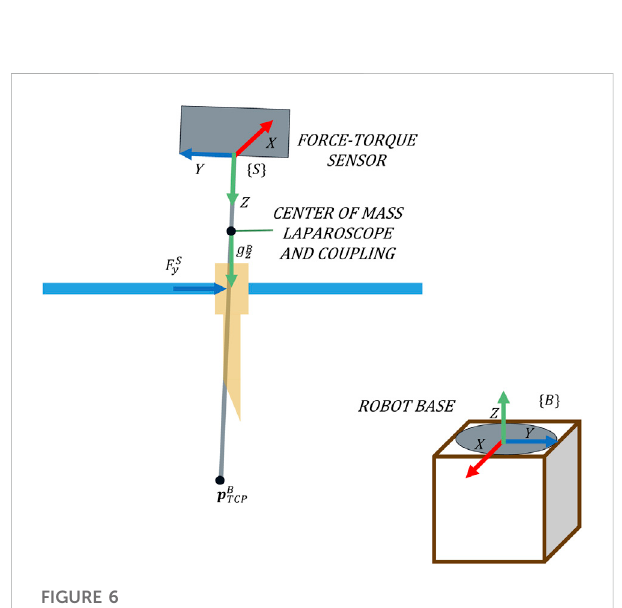
FIGURE 6 Forces measured on the trocar and their reference